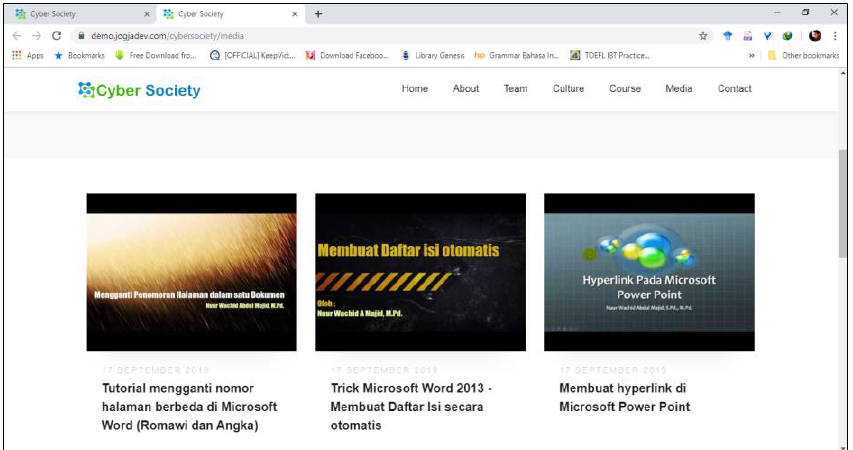
Fig. 7. Menu of Media to show media